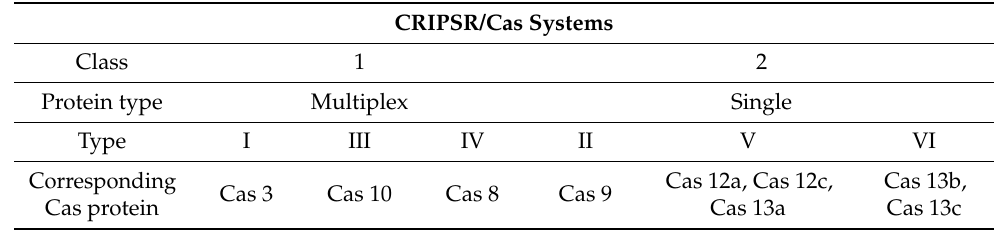
Table 1. Classification of the CRISPR/Cas